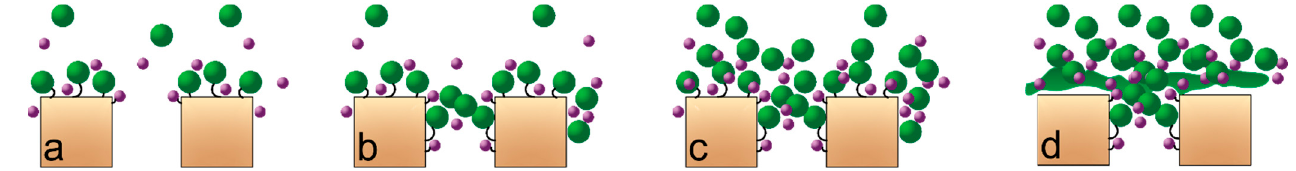
Figure 1. Membrane fouling progression: no changes in flux ( a ), permeate flux is affected ( b ), hydraulic resistance increased ( c ), and cake layer formation ( d ).